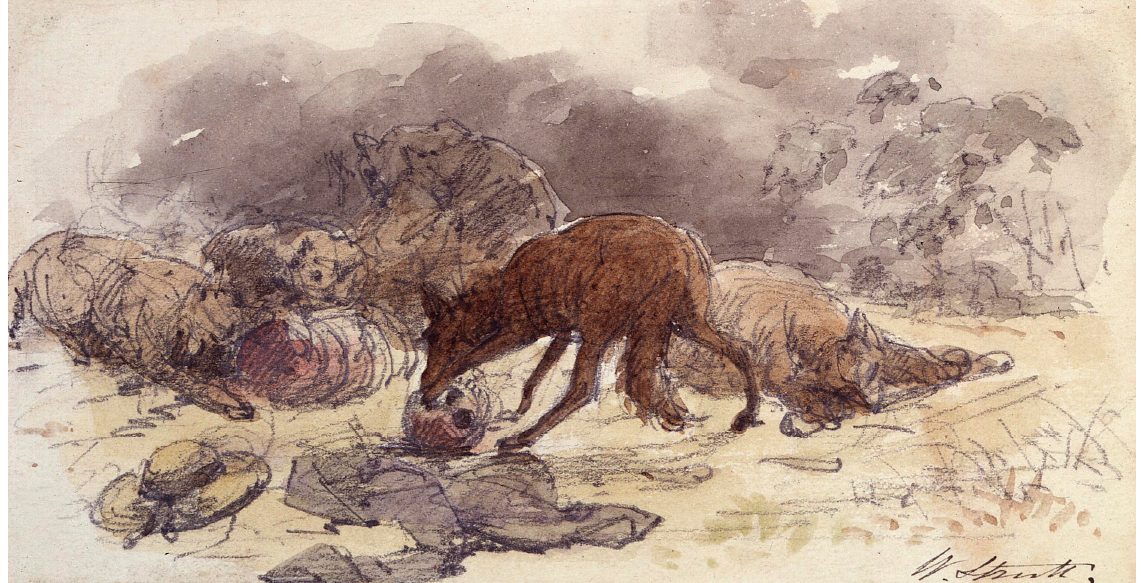
Figure A4. A depiction of dingoes scavenging the remains of explorer William Wills. Title: ‘Dingo’s (sic) devouring Wills’ remains’ (1879?). Artist: William Strutt. Image courtesy Parliament of Victoria.